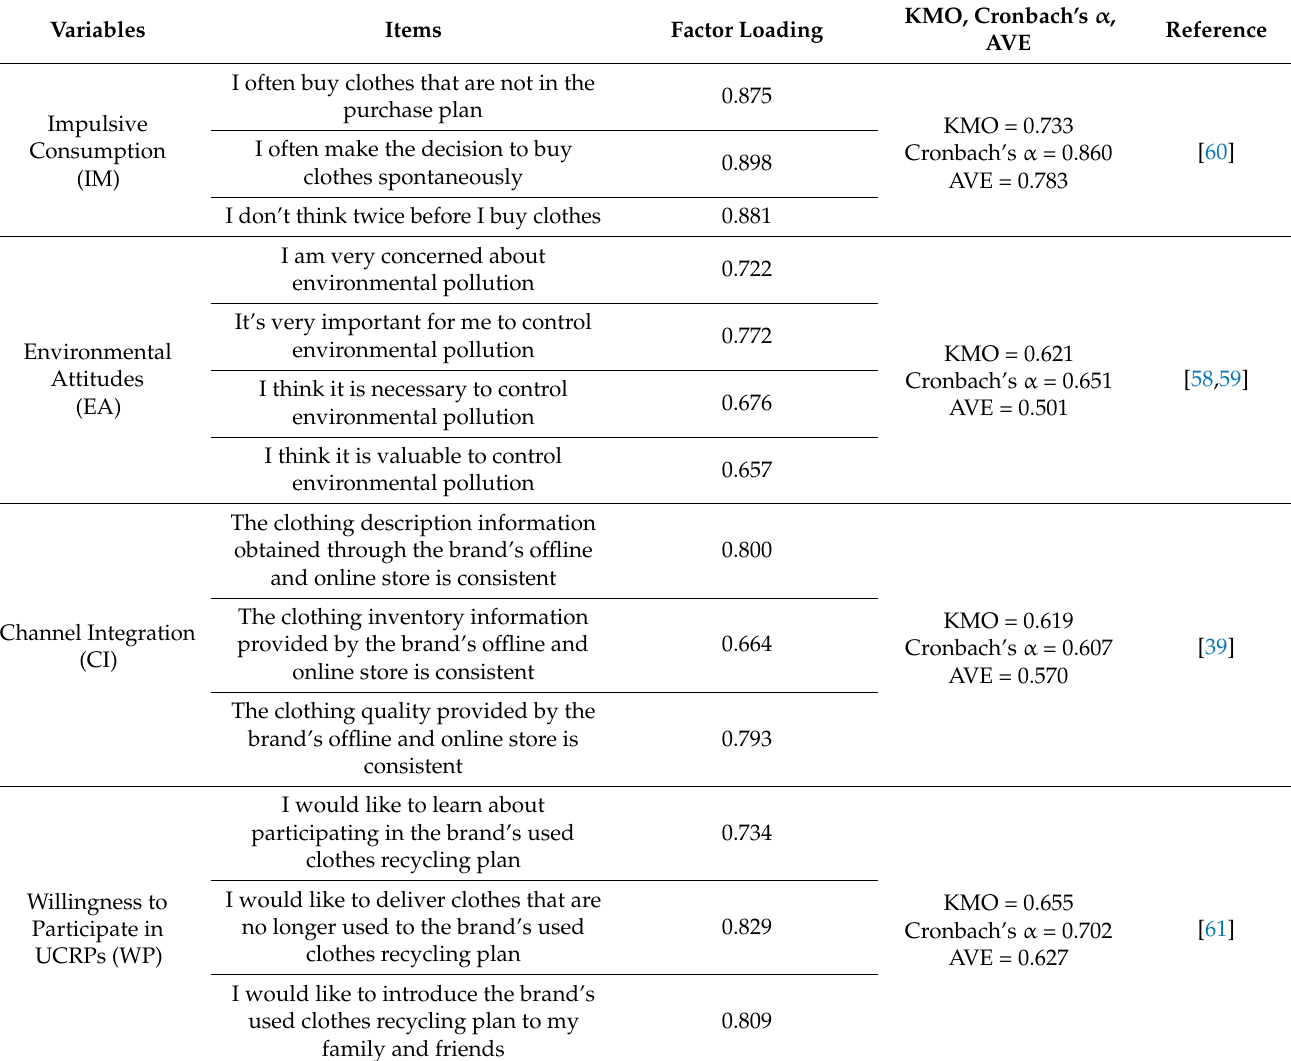
Table 2. Items, Variables, and Psychometric Properties of